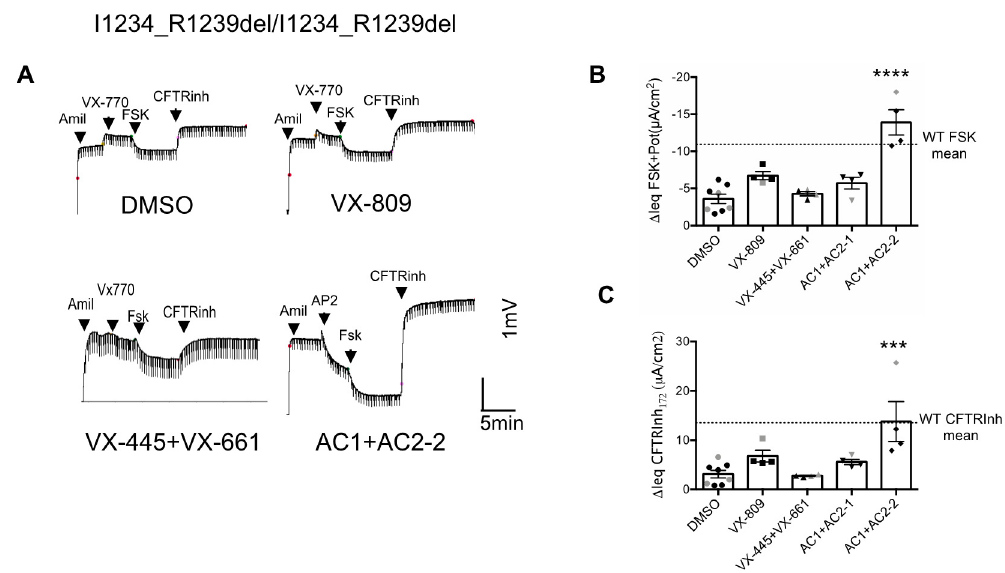
Figure 2. CFTR modulators rescued CFTR channel function in nasal epithelial cells derived from two patients homozygous for the I1234_R1239del-CFTR mutation. ( A ) Representative tracing show Ussing chamber measurements of transepithelial potential difference trace of I1234_R1239del-CFTR in nasal cell cultures pre-treated with DMSO, 3 µM VX-809, 3 µM VX-445 + 3 µM VX-661, 0.5 µM AC1 + 3 µM AC2-1, 0.5 µM AC1 + 3 µM AC2-2 for 48 h at 37 °C. ( B ) Bar graph showing mean peak responses (Ieq (µA/cm 2 ± SEM) to forskolin (10 µM) and VX-770 (1 µM) or AP2 (1.5 µM) activated Ieq for nasal cultures from 2 patients after pre-treatment for 48 h with CFTR correctors. Modulators were tested in 1–4 cultures for each patient with each data from each patient showed as grey or black symbols, peak value for culture shown as dot. ( C ) Bar graphs showing the IeqCFTR inhibition (µA/cm 2 ) by CFTRInh-172 (10 µM). (*** p < 0.001, **** p < 0.0001).